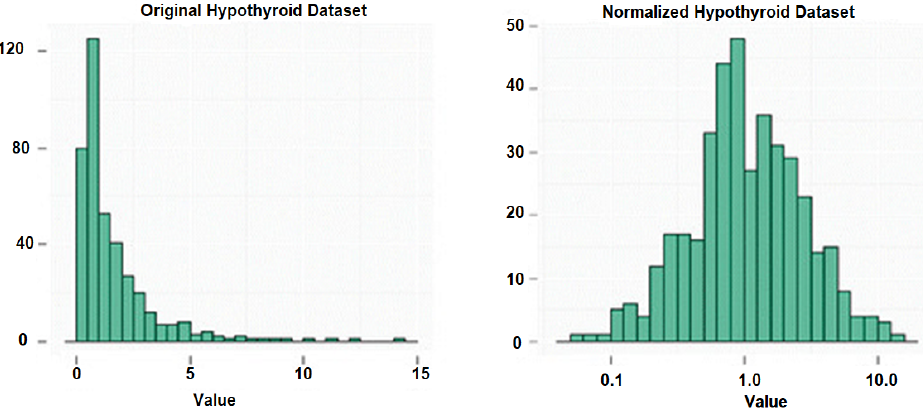
Figure 2. Normalization of the hypothyroidism dataset.